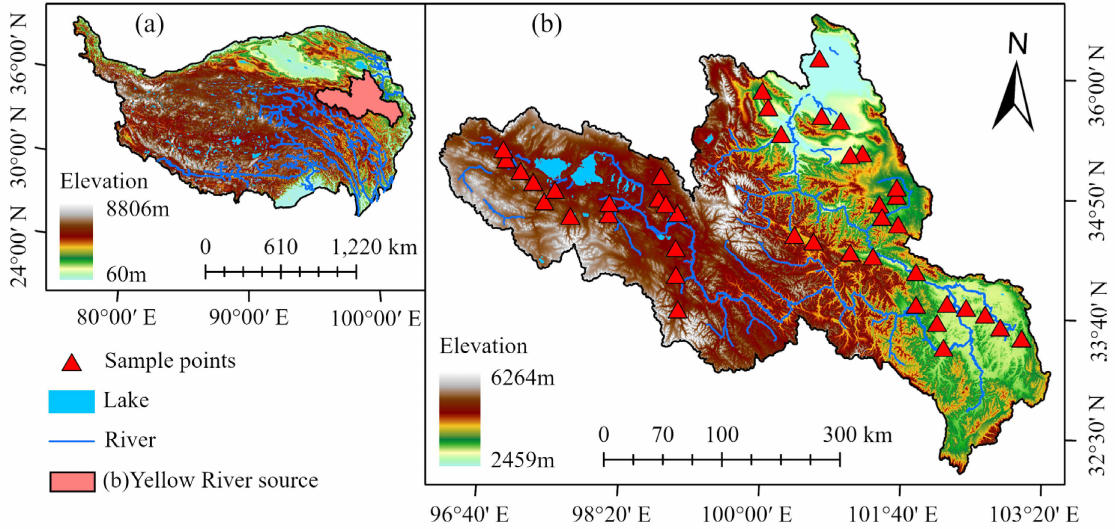
Figure 2. Qinghai–Tibet Plateau ( a ), the source region of the Yellow River, and the locations of sampling points ( b